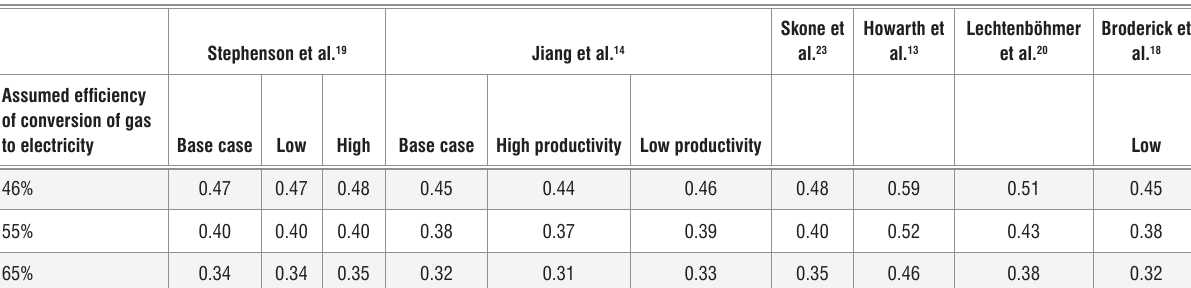
Assumed efficiency of conversion of gas